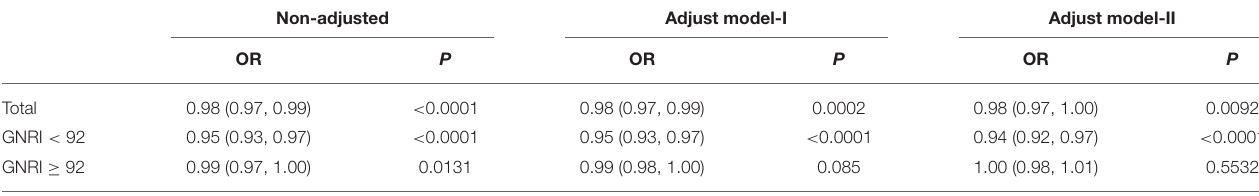
TABLE 7 | Threshold effect analysis of GNRI on in-hospital mortality. Non-adjusted Adjust model-I Adjust model-II